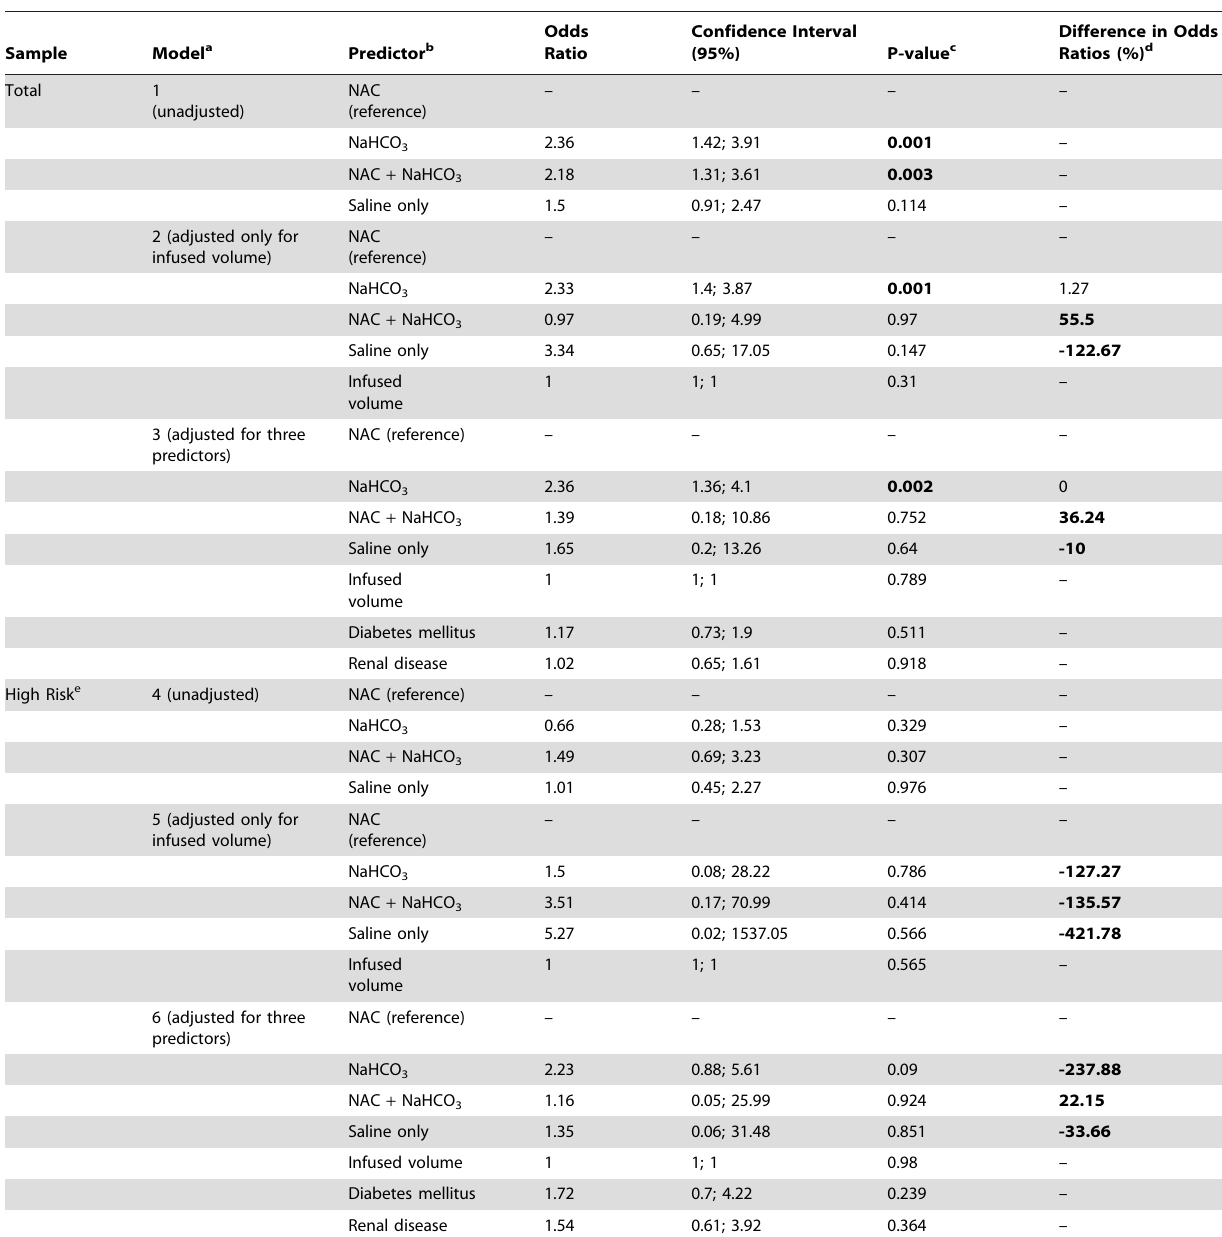
Table 3. Multiple logistic regression analysis of potential